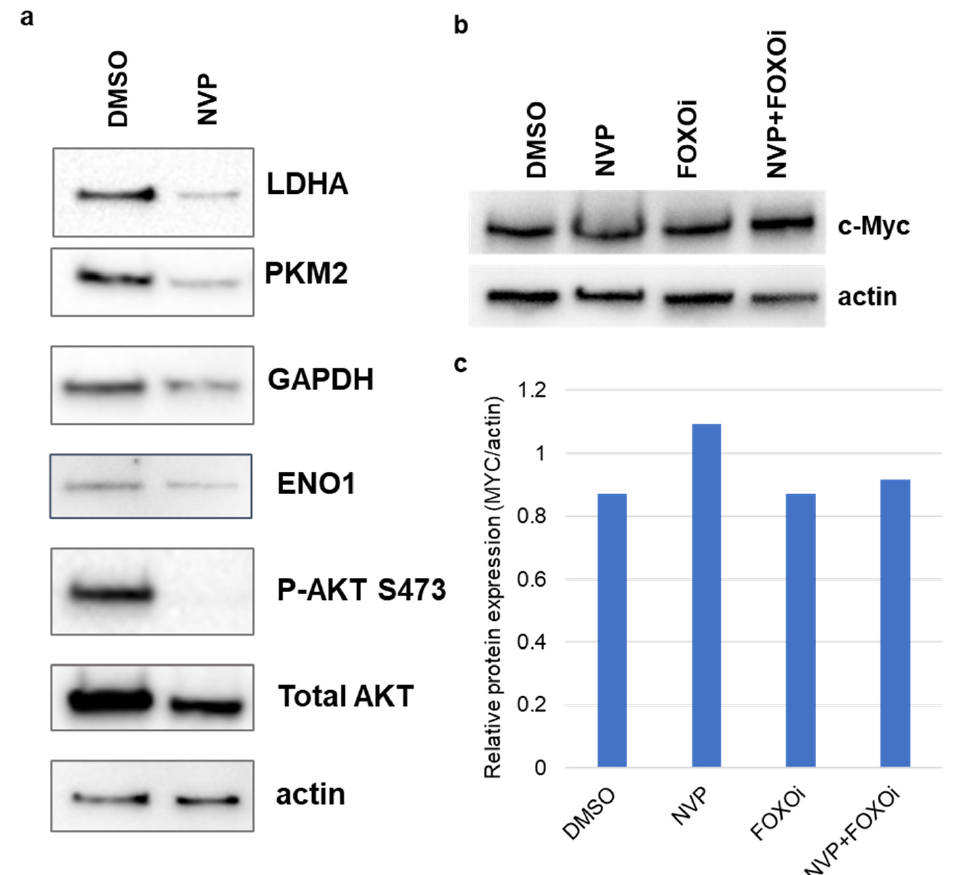
Figure 6. Expression changes of glycolysis-related proteins. Protein expression was verified using Western blot analysis in U87MG in ( a ) DMSO and 1 µ M NVP-BEZ235 (NVP) samples, ( b ) c-Myc protein expression was verified using Western blot analysis in DMSO, NVP, FOXOi (AS1842856), and NVP+FOXOi samples (1 µ M of each drug). Actin was used as the loading control. ( c ) Western blot for c-Myc was quantified using the Image Lab Software (Bio-Rad).